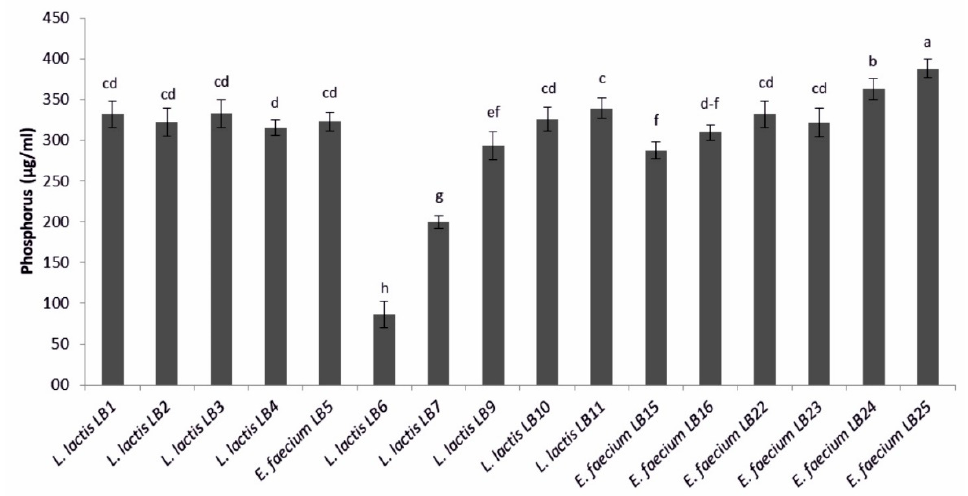
Figure 2. Amount of phosphorus solubilized by lactic acid bacteria. Means ( ± SD) followed by the similar letter(s) are not significantly different at the 5% probability level (LSD test).